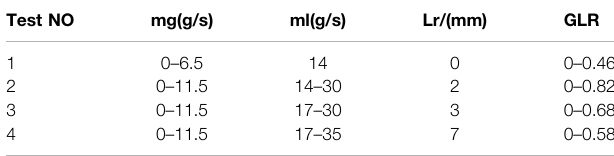
TABLE 2 | Operating conditions in experiments.